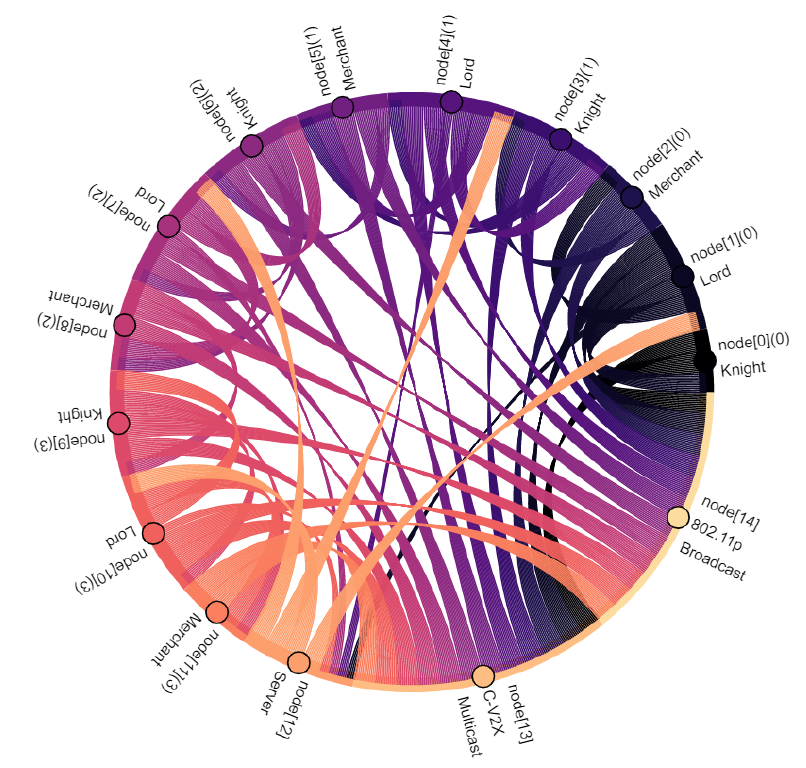
Figure 15. The communication data flow within a platoon performing Feudalistic Platooning